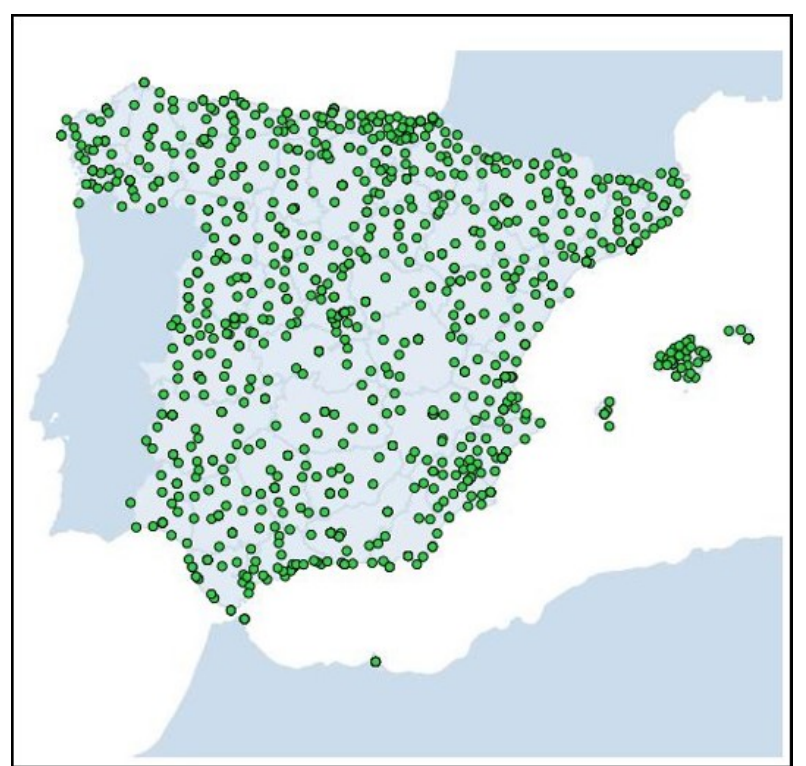
Figure 4. Flood in the Vega Baja of the Segura River (Alicante, Spain), 11–14 September 2019. Source: Generalitat Valenciana [69].